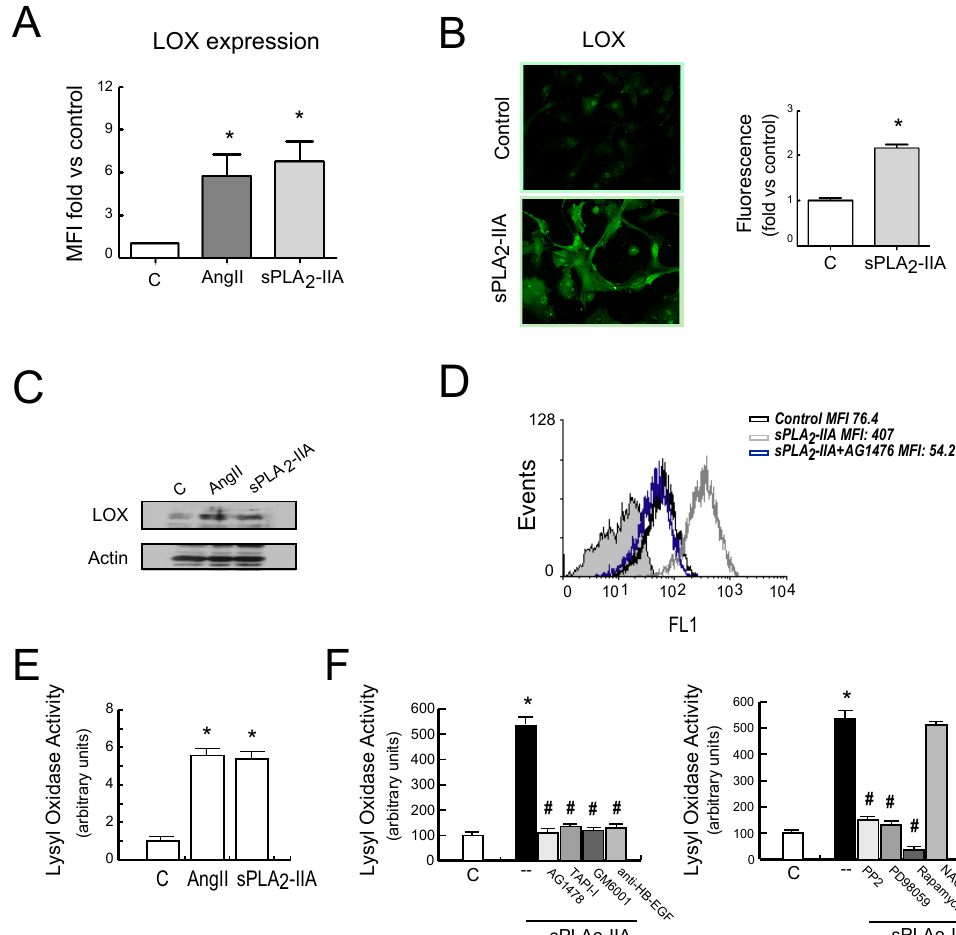
Figure 8. sPLA 2 -IIA induces LOX expression in cardiac fibroblast (CFs) via EGFR transactivation. CFs were treated with 1 μg/mL of sPLA 2 -IIA or 1 μM AngII for 24 h and LOX protein expression was evaluated by ( A ) flow cytometry analysis, ( B ) fluorescence microscopy and ( C ) Western blot. ( A ) The graphic represents the mean fluorescence intensity (MFI) and is shown by fold control. (B) Representative microphotographs (objective lens 20×, magnification 200×) and quantification. ( C ) Representative Western blotting in total cell lysates. ( D ) CFs, pretreated with the EGFR inhibitor AG1476, were stimulated with 1 μg/mL of sPLA 2 -IIA for 24 h. LOX expression was analysed by flow cytometry. Representative histograms are shown, n = 3. Untreated cells (open black curves) were compared with sPLA 2 -IIA-treated cells in the absence (open dark grey curves) or presence of inhibitor (open blue curves). Solid light grey curve represent isotype control. CFs were stimulated with the indicated agonists ( E ) or with 1 µ g / mL of sPLA 2 -IIA in presence of the indicated inhibitors ( F ) for 24 h, and LOX activity was measured in cell culture medium. Bar graphs represent the mean ± SD; n = 3. * p < 0.001 vs. control cells, # p < 0.001 vs. sPLA 2 -IIA-treated cells.